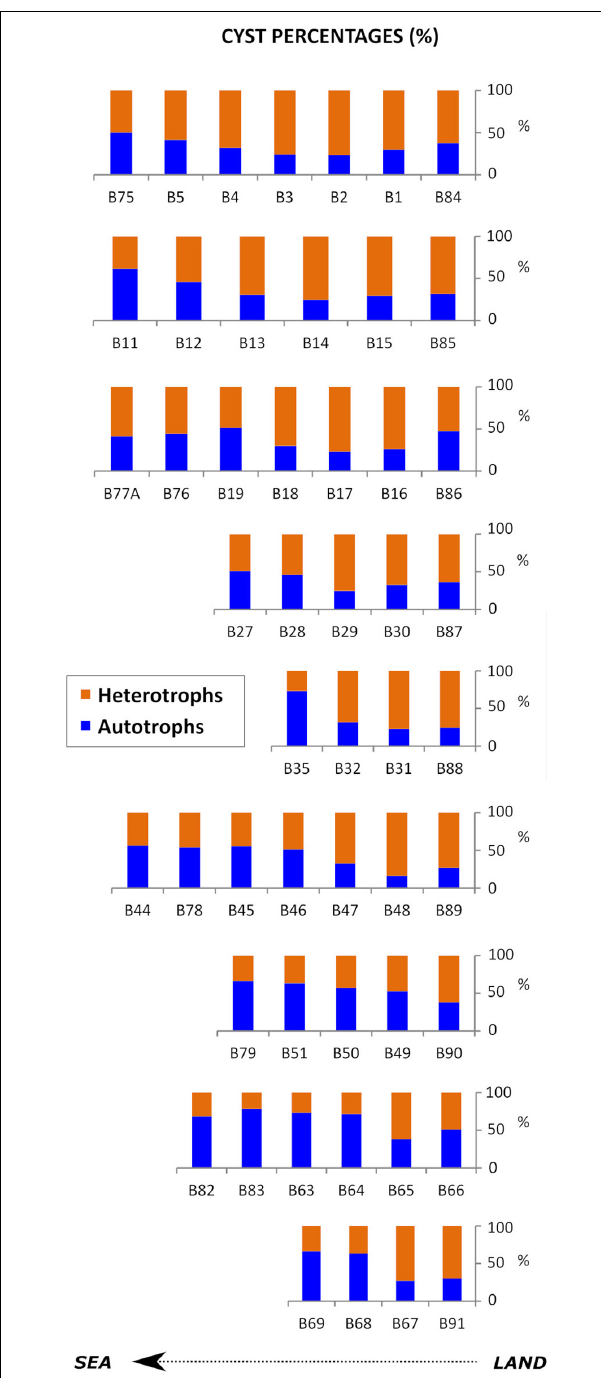
FIGURE 4 | Spatial trends in relative abundances (%) of heterotrophic (orange) and autotrophic (blue) taxa along the nine land-sea transects studied.